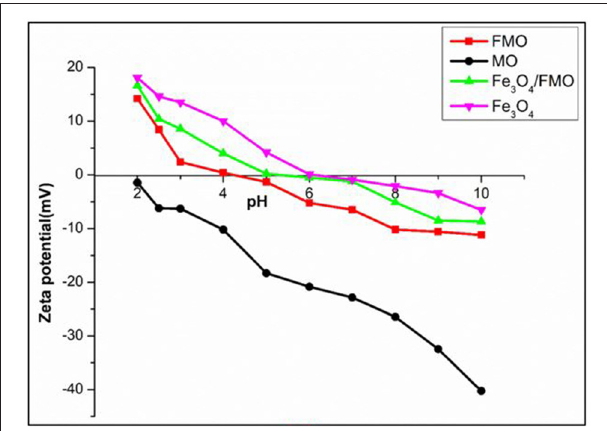
FIGURE 5 | Determination of the surface charge of MO, FMO, Fe 3 O 4 , and Fe 3 O 4 /FMO using the Zeta potential.